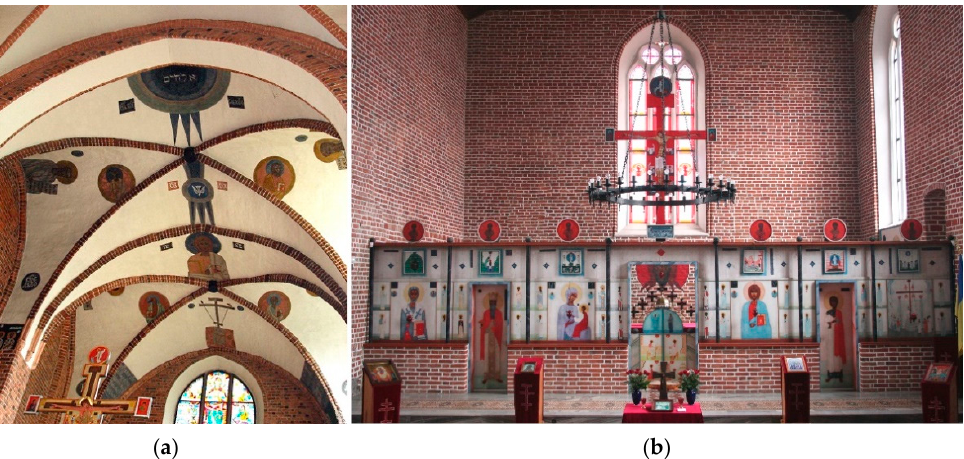
Figure 17. Nowosielski’s polychrome of gothic churches: ( a ) the Orthodox Cathedral in Wrocław. ( b ) Greek Catholic church in G ó rowo Iławeckie. Photography by the author. In G ó rowo Iławeckie in Masuria, the artist adapted an unused post-Evangelical aisleless church built in the Gothic style around 1367 (Kapka 2018). A characteristic feature of the existing interior were raw brick walls in a cool red color with a contrasting pattern of white joints. Nowosielski designed an iconostasis and polychrome of the walls (Figure 17b). The iconostasis was located on a plinth identical to the walls. The color scheme of paintings reflected the existing interior colors, but in inverted proportions: the dominant color is white contrasted with red elements—small circular icons and a cross crowning the iconostasis, as well as a large halos that is a part of the Mandylion on the back wall of the chancel. The palette is complemented by sparingly dosed blues, yellows, and browns of saints’ complexions. The project in G ó rowo Iławeckie shows Nowosielski’s extraordinary abilities to use the existing qualities of the interior. Thanks to this, he was able to achieve spectacular artistic effects with modest